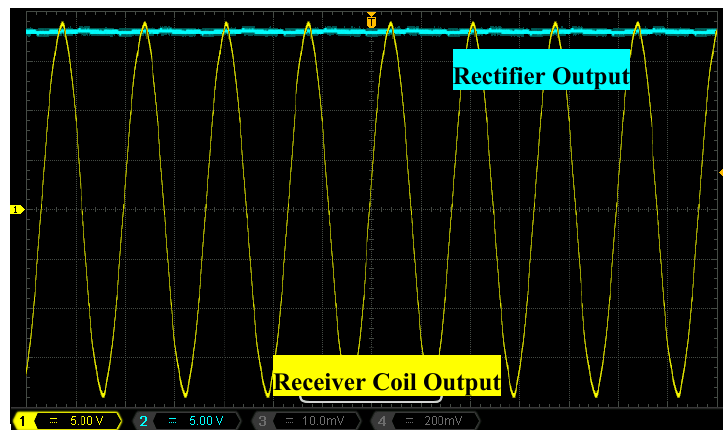
Figure 17. Receiver coil and rectifier output waveforms to charge the EV battery.